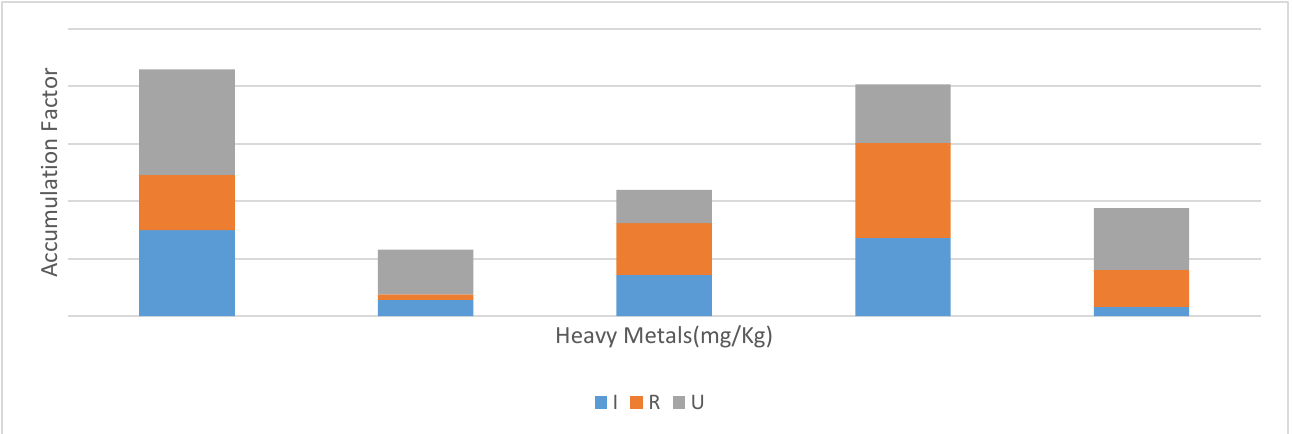
Figure 3. Pollution indices across study stations in soils ( a ) and Vernonia amygdalina Delile ( b ). Figure 3. Pollution indices across study stations in soils (c) and Vernonia amygdalina Delile (d) .